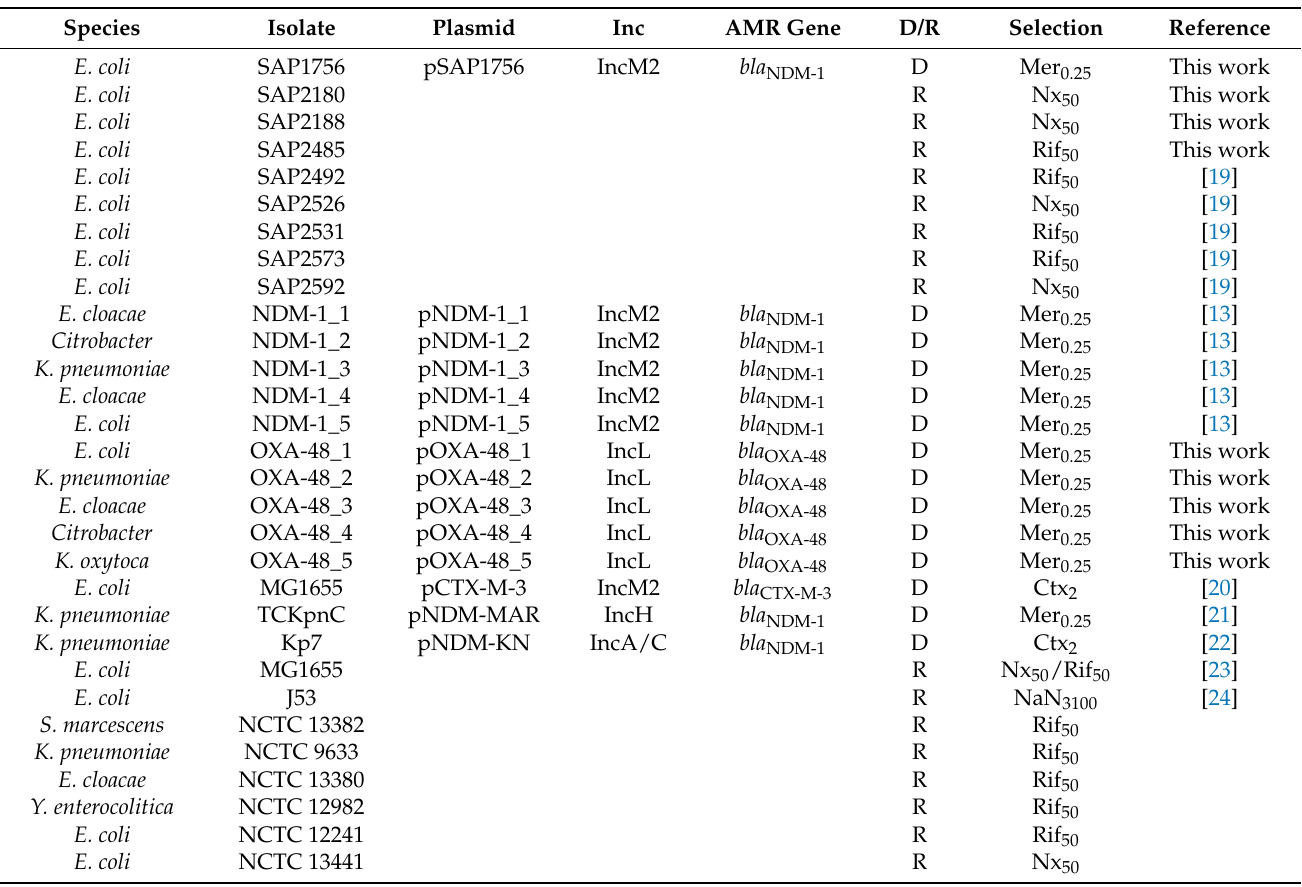
Table 3. Bacterial strains and plasmids used in this